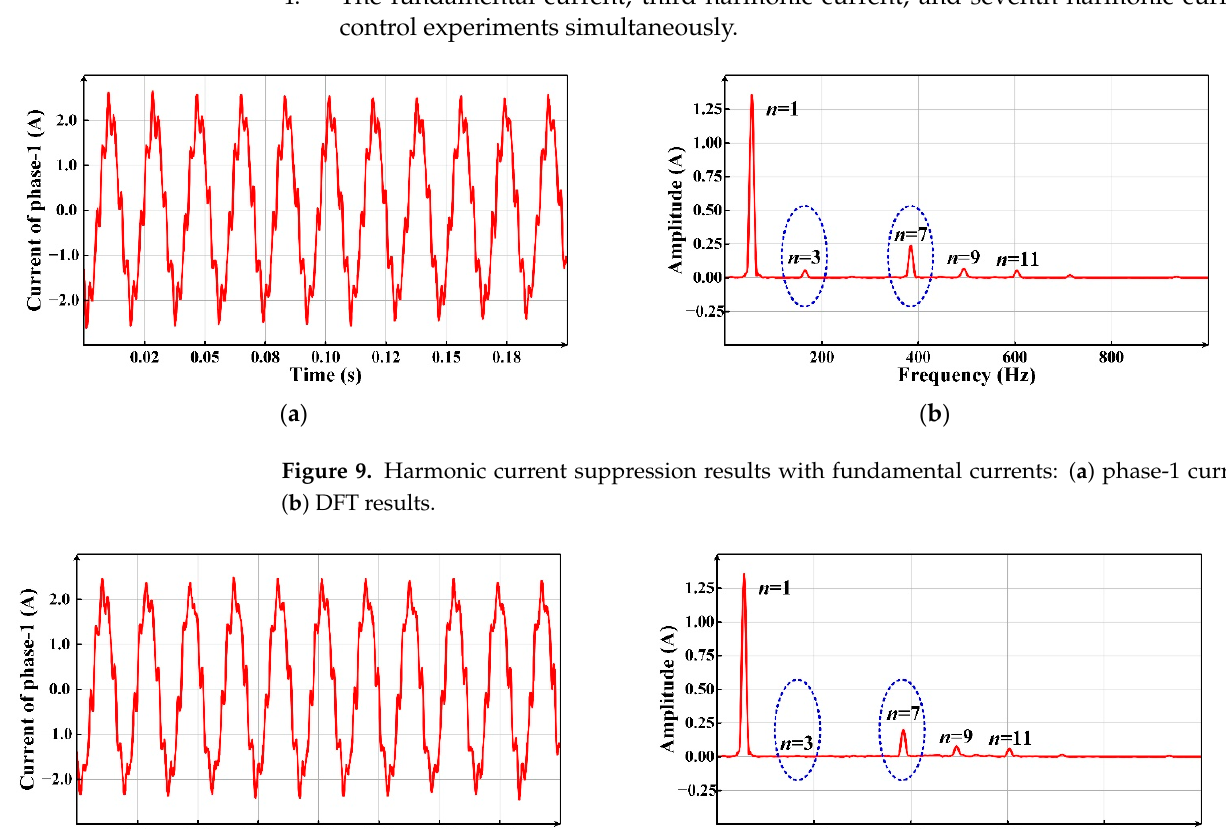
( b ) Figure 11. Harmonic current suppression results with fundamental currents and seventh harmonic current: ( a ) phase-1 current; ( b ) DFT results. ( a ) ( b ) Figure 12. Harmonic current suppression results with fundamental currents, third harmonic cur- rent and seventh harmonic current: ( a ) phase-1 current; ( b ) DFT results. Table 3. Harmonic current suppression results. The Experiment and Harmonic Current Order